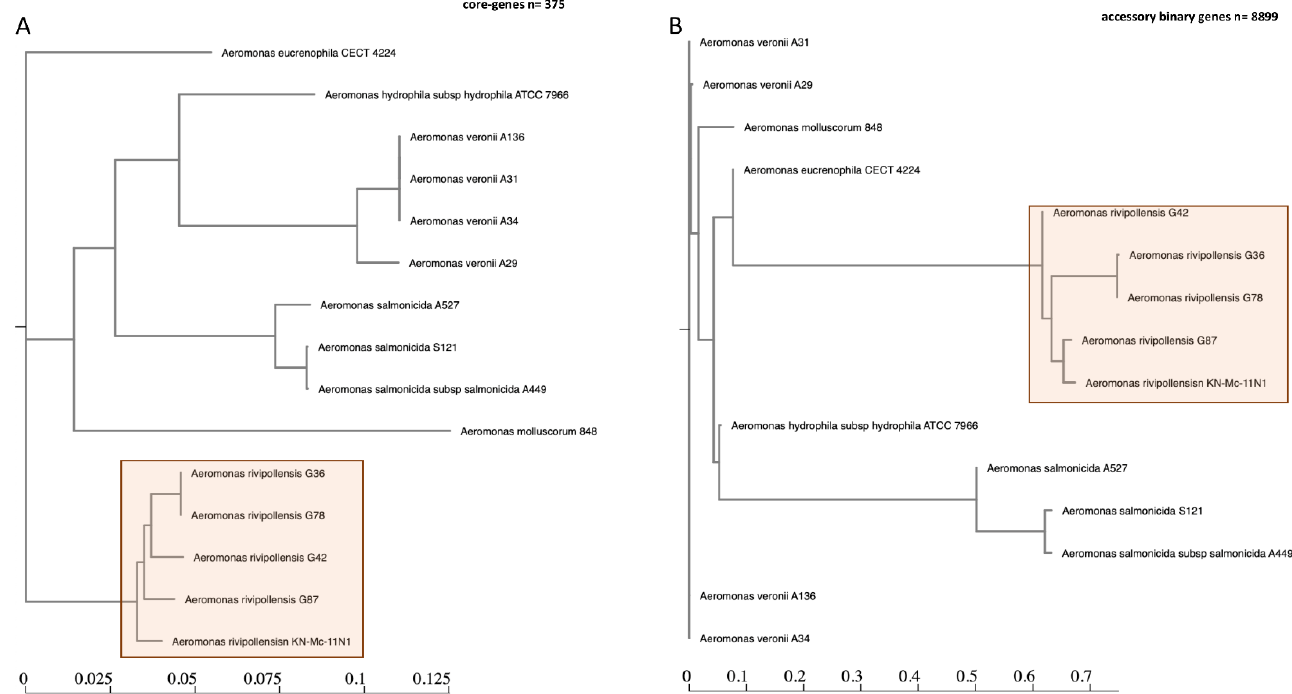
Figure 2. Phylogeny of the compared Aeromonas species using 375 core genes ( A ) and 8899 accessory binary genes ( B ). The tree shows phylogenetic tree of the 4 Aeromonas species as highlighted with orange color. About 375 core-genes ( A ) and 8899 accessory binary genes ( B ) were used to construct the phylogenetic tree.